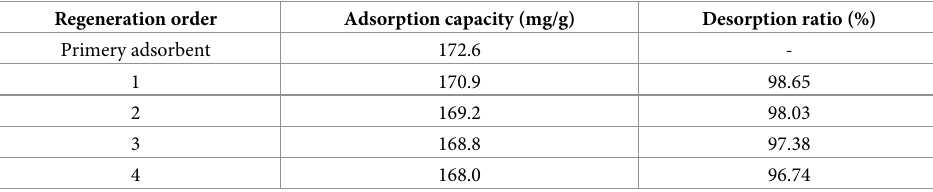
Table 11. Desorption ratio of ciprofloxacin and reusability of AFBG